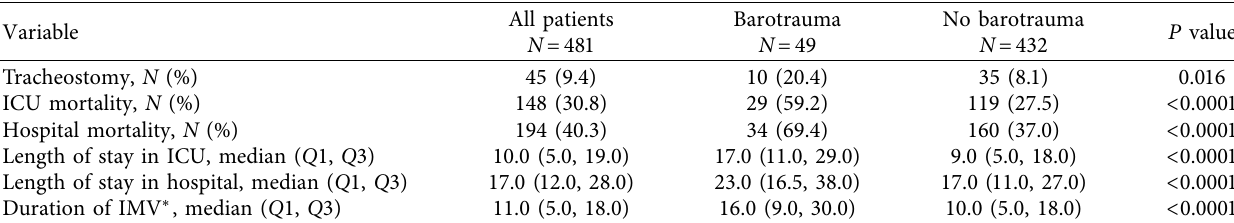
Table 3: Te outcomes of patients with critical COVID-19 categorized by the occurrence of pulmonary barotrauma. Variable ICU mortality, N (%) Length of stay in hospital, median ( Q 1, Q 3)